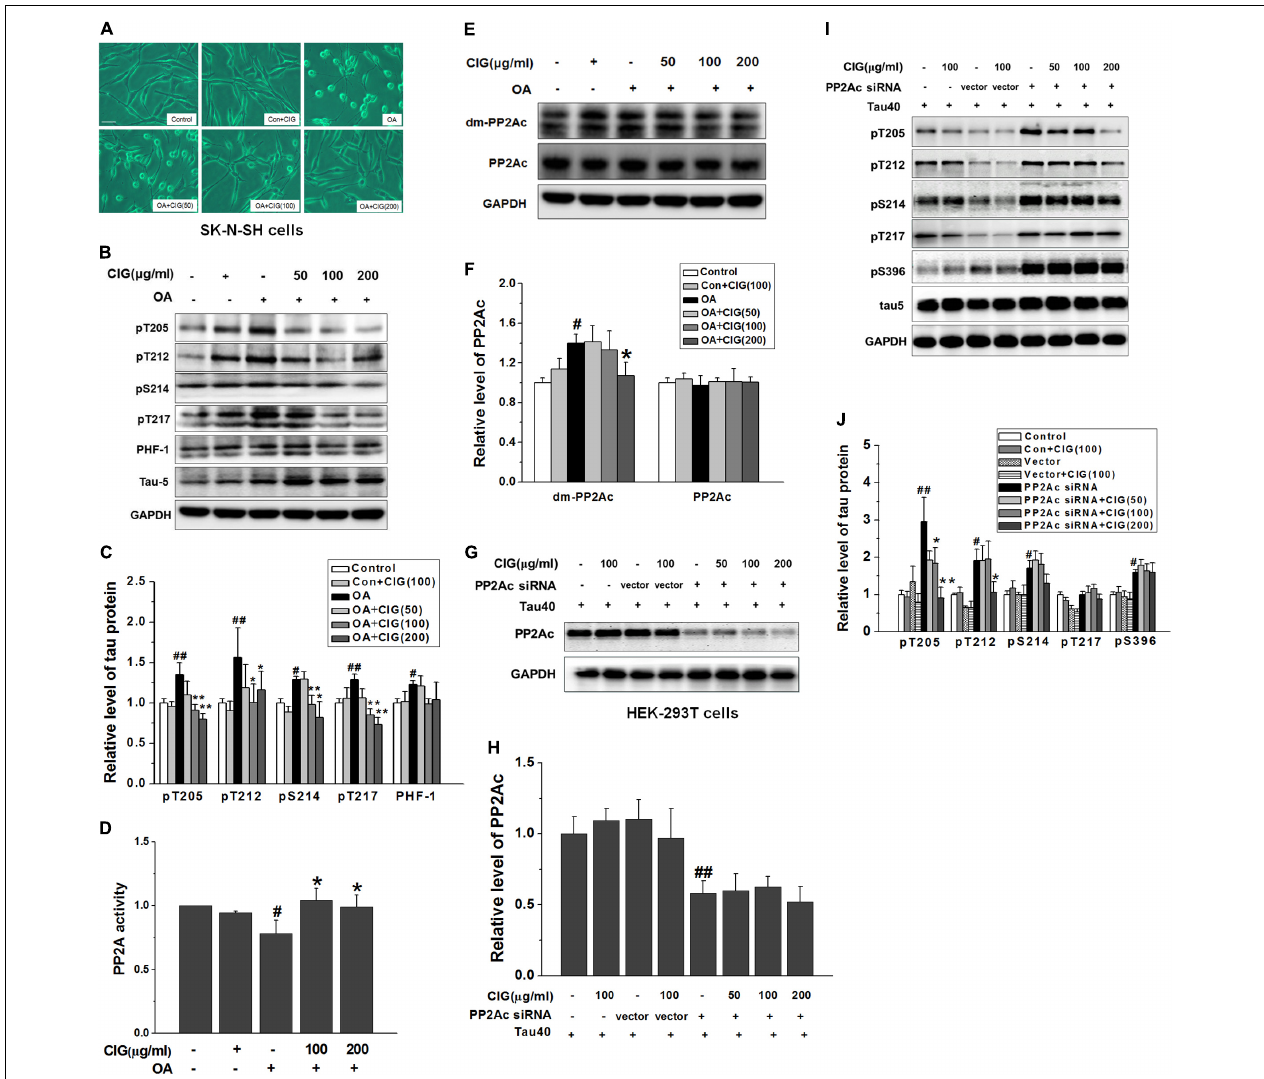
FIGURE 4 | Cornel iridoid glycoside enhances PP2A activity through inhibiting PP2Ac demethylation directly. (A) The morphological changes of human neuroblastoma SK-N-SH cells exposed to okadaic acid (OA) at the dose of 20 nM for 6 h were observed under contrast microscope (Scale bar = 50 µ m). CIG